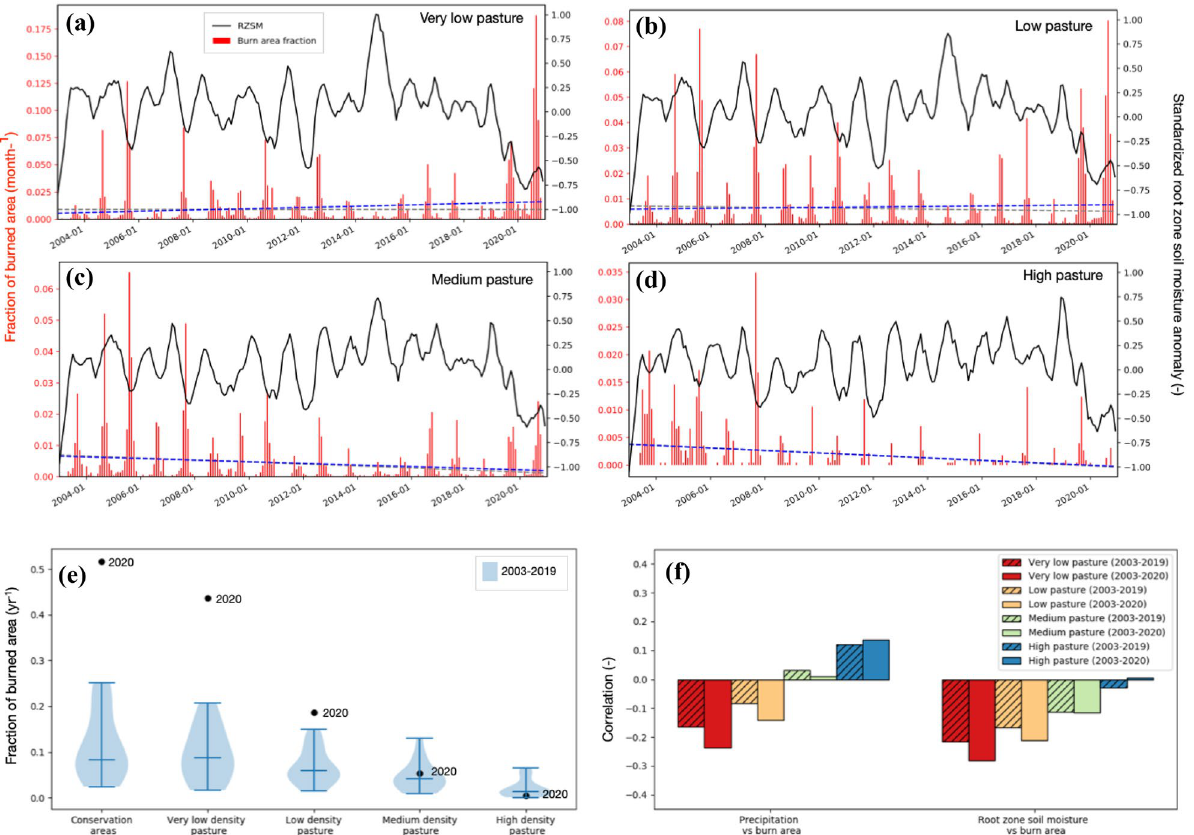
Figure 2. Time series of the standardized anomalies of antecedent 6-month root zone soil moisture (black lines) and fraction of burned areas per month (red bars) over areas with different pasture density (panels a , b , c , d ). The dashed blue and gray lines show the linear trend of the monthly fraction of burned area (Table 1) over the 2003–2020 and 2003–2019 time periods, respectively. Panel e shows the distribution of annual fraction of burned area across 2003–2019 and from 2020 and Panel f shows the Spearman correlation between the standardized anomalies in variables relevant for fuel moisture (i.e., 12-month precipitation, 6-month root zone soil moisture) and percent of burn area, stratified for areas with four different levels of pasture density.